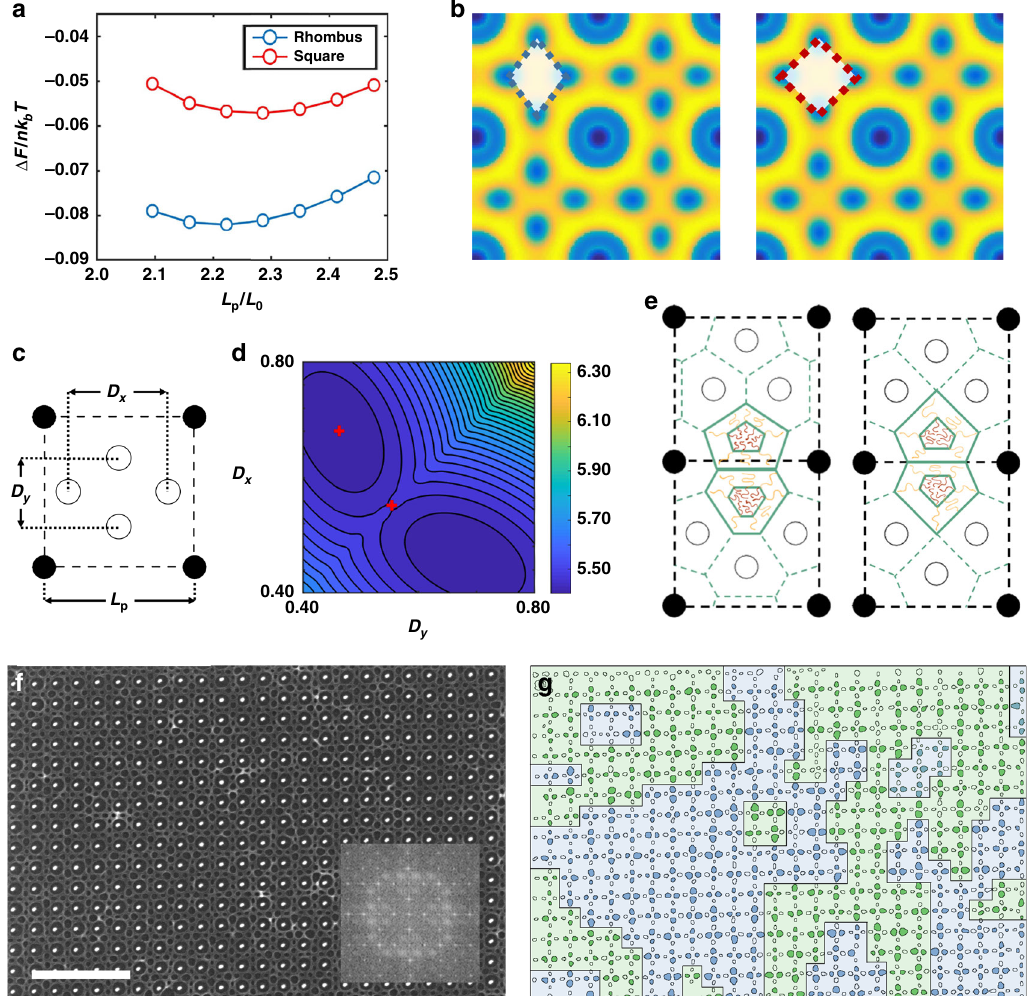
Fig. 2 SCFT simulation, analytical model, and large-scale SEM. a Free-energy comparison of rhombus and square shape PS domains from SCFT. b Density pro fi le comparison of P4VP block in SCFT simulations, where the blue represents 100% density of the PS phase and yellow 100% density of the P4VP phase. c D x and D y (two axes de fi ned in the SST-based analytical model) scaled with respect to L p (inter-post distance). d Contour lines of the total free- energy landscape with different D x and D y . The minimum energy is reached when D x = 0.68 L p and D y = 0.46 L p . The two red plus signs indicate the geometries shown in e . The color scale is the free energy in units of nk b T . e Wigner-Seitz cell when D x = 0.68 L p and D y = 0.46 L p and when D x = D y = 0.54 L p , respectively. f SEM of large area of the sample with Fast Fourier Transform (FFT) inset. g Contours of the PS domains, with the boundaries between the two possible variants indicated. The scale bar in f is 500